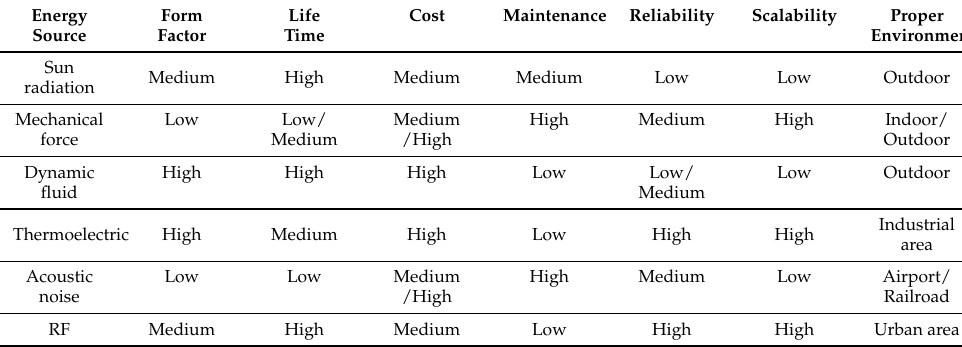
Table 4. Energy source characteristics.